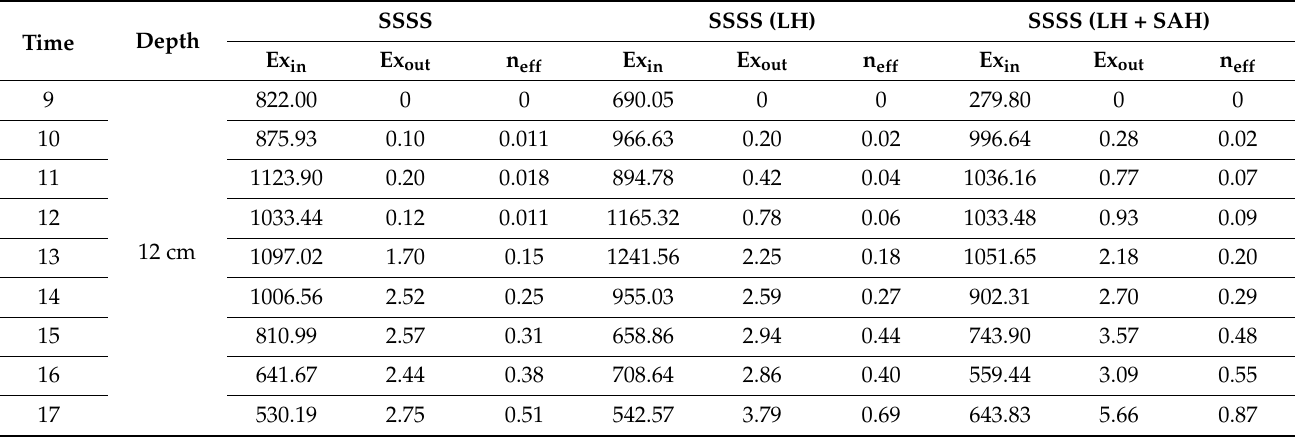
Table 6. Exergy analysis of SSSS, SSSS (LH) and SSSS (LH + SAH) at the depth of 12